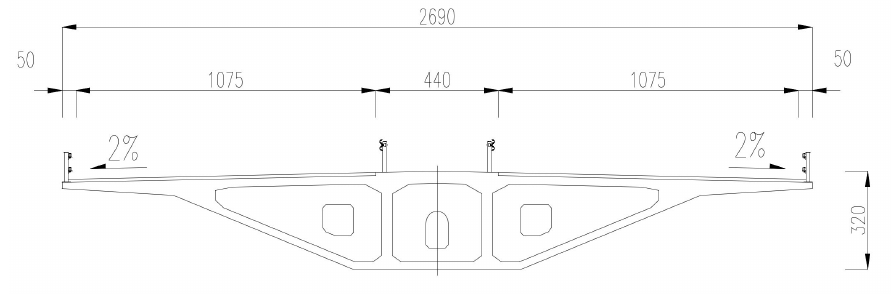
Figure 4. Cross section of the cable-stayed bridge (unit: